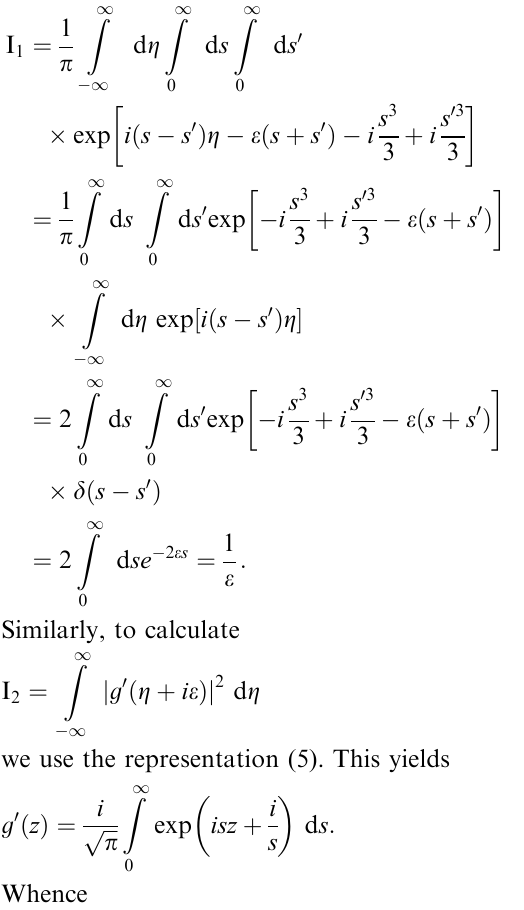
Fig. 5. Mean square of the amplitude of a two- dimensional random vector r (cid:136) (cid:133) x ; y (cid:134) with specified quadratic correlators < x 2 >;< y 2